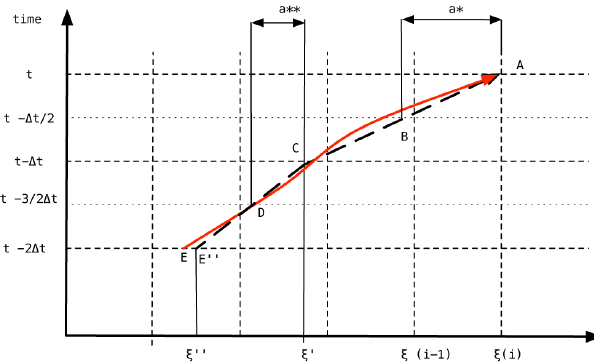
Figure 5. Schematic for the two-step three time level scheme for one dimension ( ξ ). The red solid curve is the actual trajectory of a particle and the dashed line is the approximation. a ∗ is the dis- placement to the intermediate position where the velocity is evalu- ated and a ∗∗ is the displacement of the second